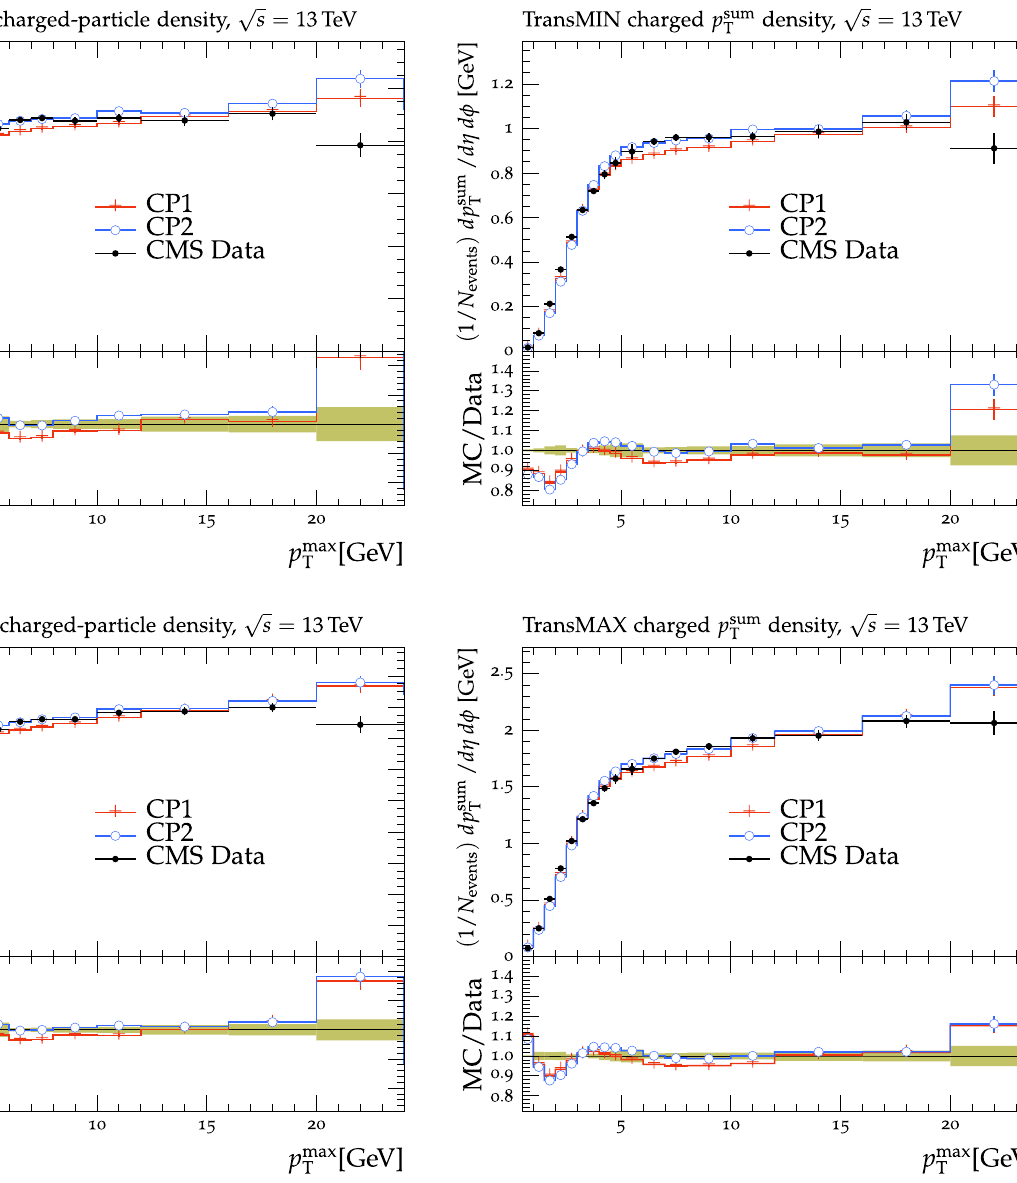
main motivation why this choice of variation was